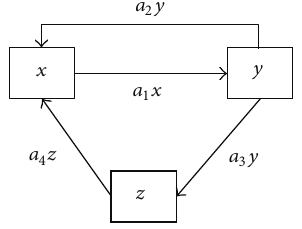
Figure 1: Flow chart of the population dynamic